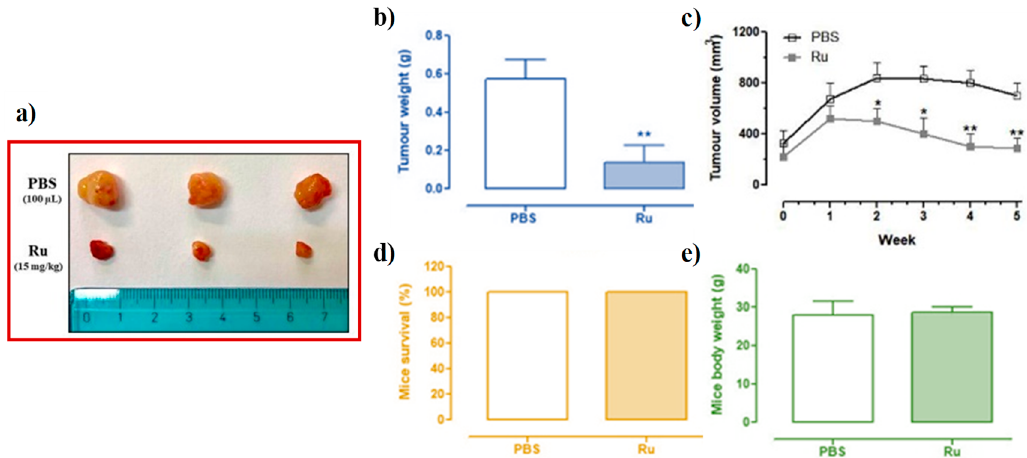
Figure 16. In vivo anticancer effects of HoThyRu/DOTAP nanosystems: tumour photographs after the collection ( a ); tumour weight ( b ) and tumour size ( c ) evaluation; mice survival ( d ) and body weight ( e ) determination (PBS control group, Ru treated group). Figures are adapted from [100].